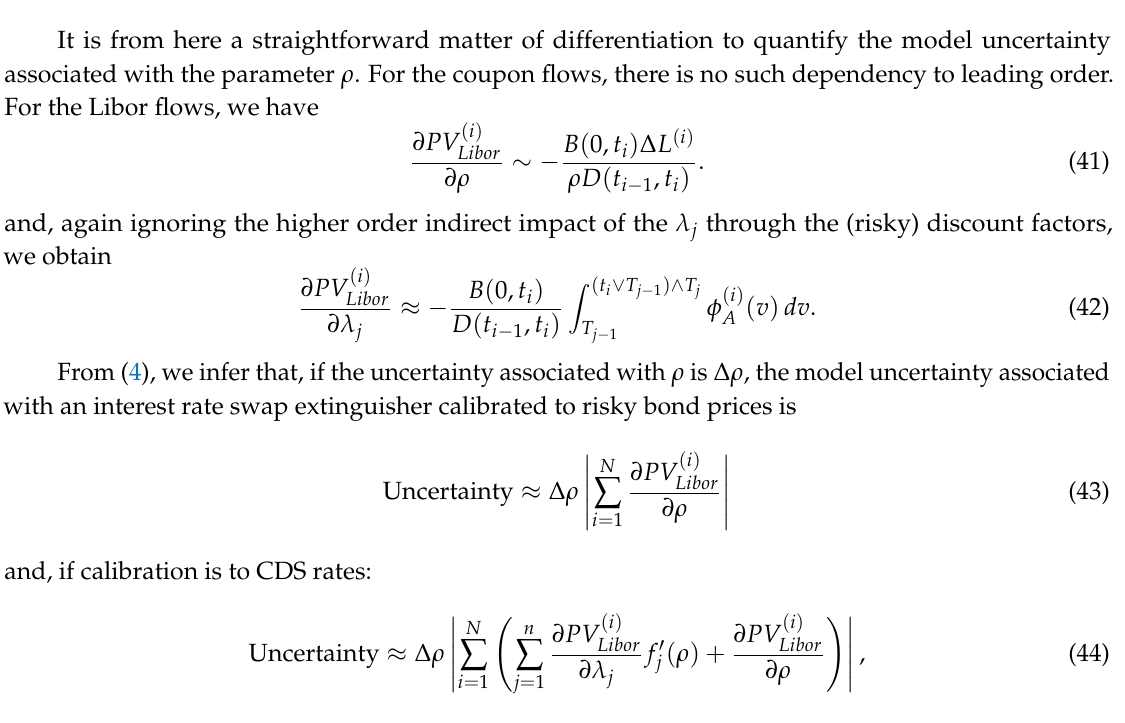
Figure 1. Impact of correlation on PV for a 5 y maturity interest rate swap